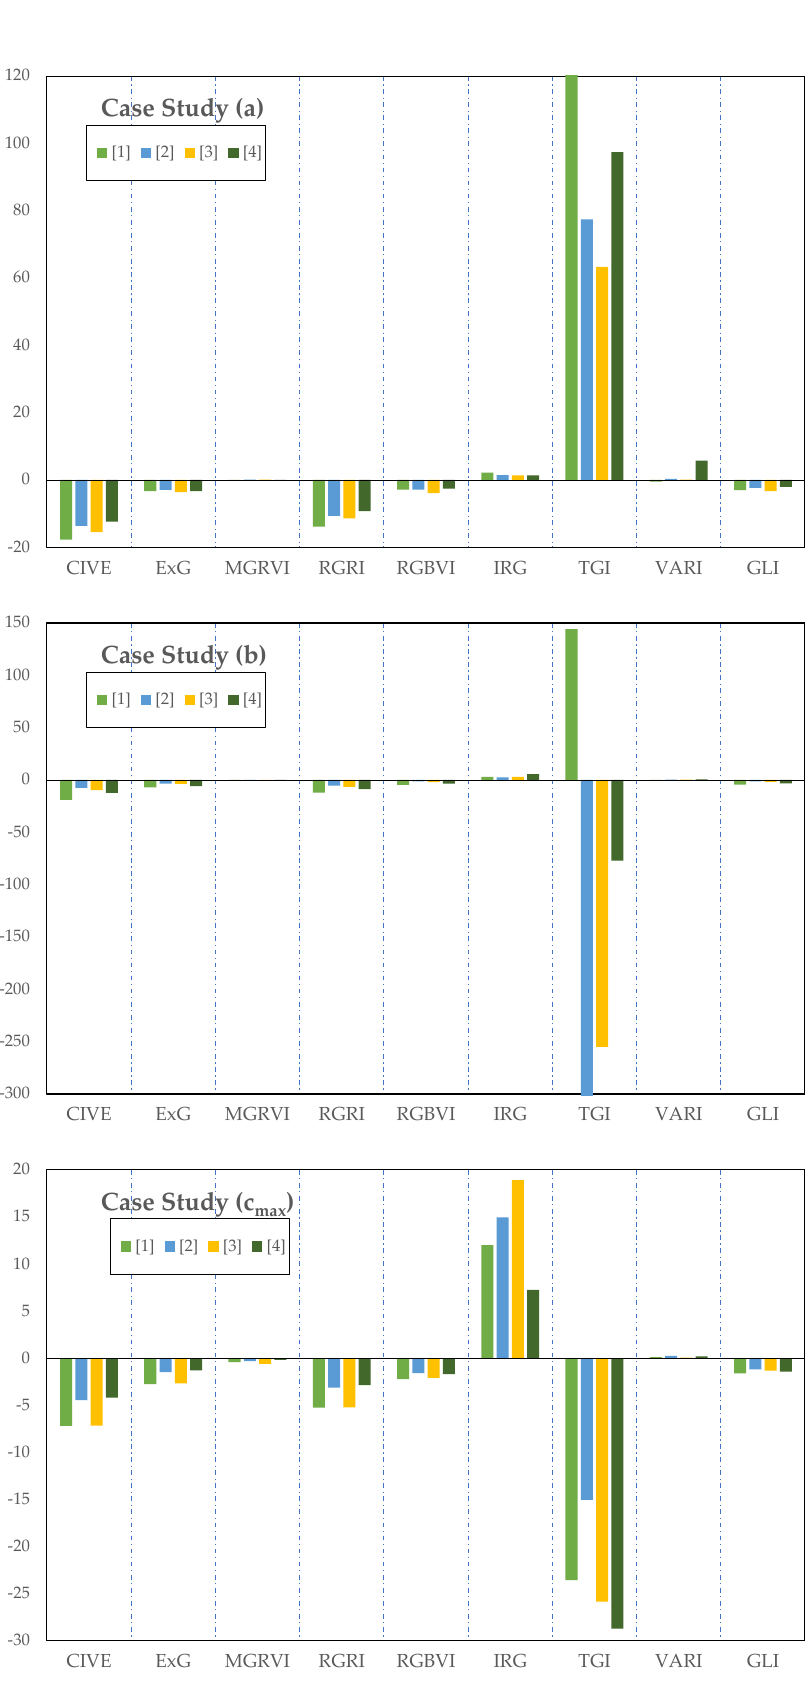
Figure 7. Normalised difference (%) for all case studies among all vegetation indices concerning the NGRDI index is considered the